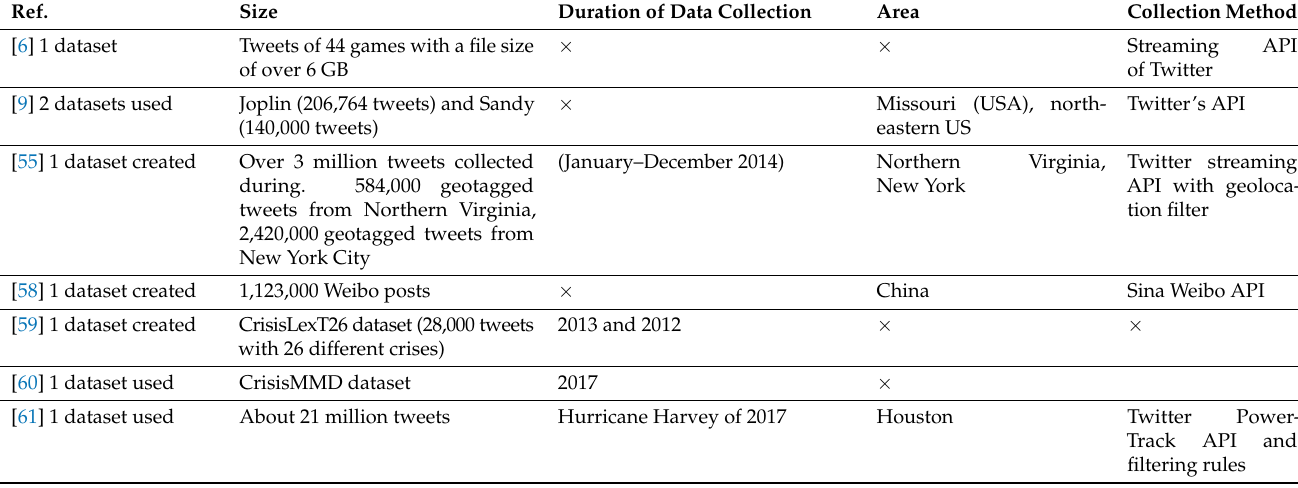
Table 5. Deep-ML-based articles’ used datasets and their related information: presenting total datasets created, size of datasets, duration of data collection, geographical area, and their collection method.